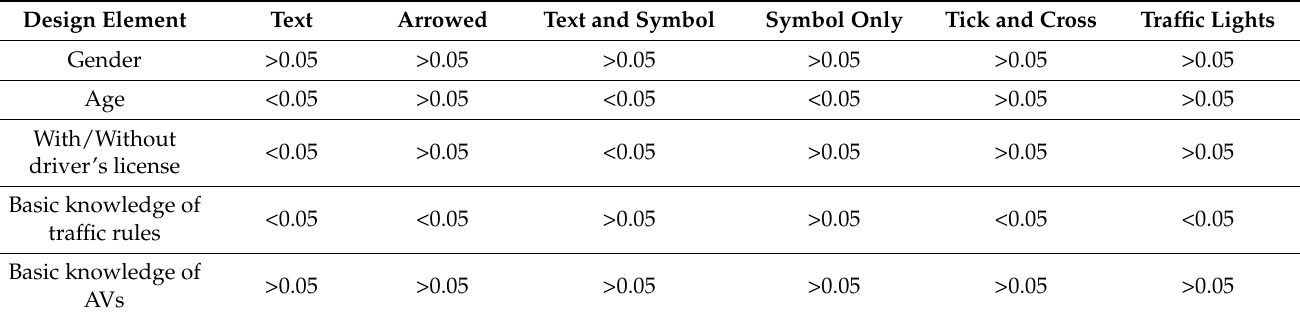
Table 4. The p values of six types under different characteristics. If p < 0.05, the evaluation scores between factors were